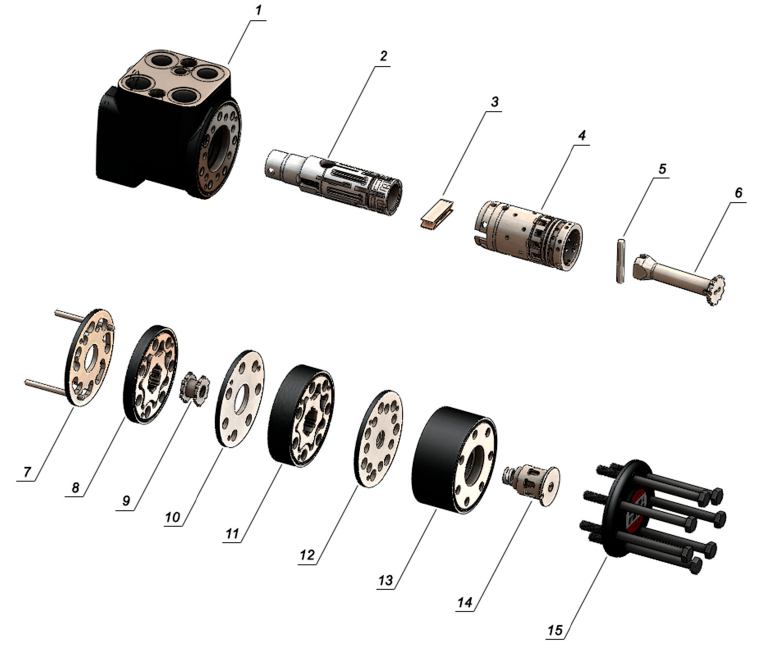
Figure 2. Components of the hydrostatic steering unit.